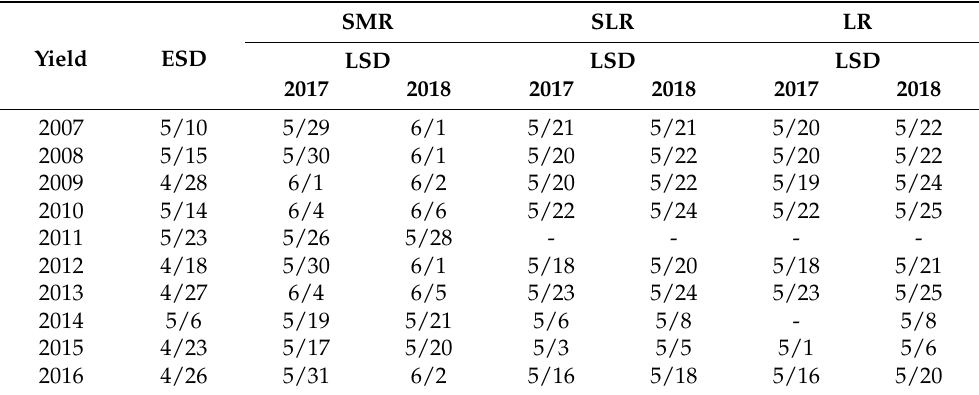
Table 9. The range of suitable sowing dates over the years was deduced according to the requirement of EAT in the grain filling stage for rice to obtain good eating quality 1